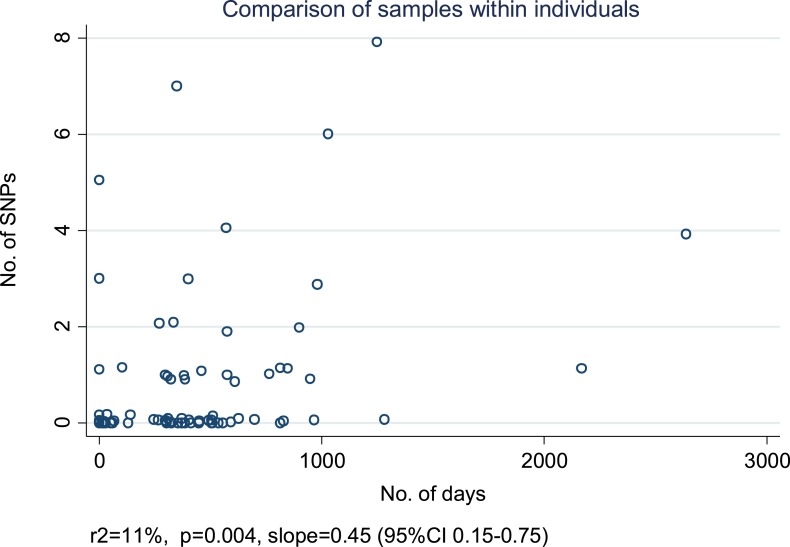
Relationship between number of SNPs and the number of days between
samples from individuals with more than one specimen available from the
same of episode of disease or from a relapse.For each individual, we selected the first and last specimens if there
were more than two. (Random noise has been introduced to allow multiple
similar results to be visualized.) The slope is given in SNPs/year.